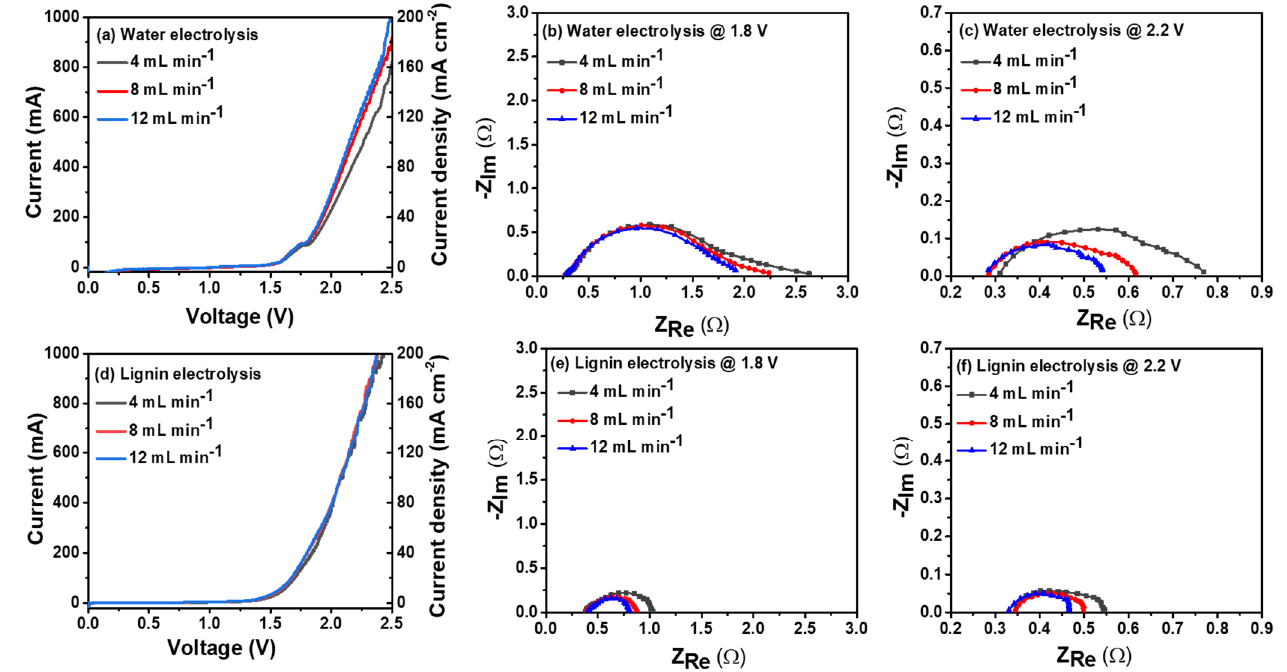
Figure 3. Effect of flow rate on the performance determined by performing linear sweep voltammo- gram (LSV) for ( a ) water electrolysis and ( d ) lignin electrolysis. The change in the ohmic and charge transfer resistance concerning the flow rate is determined by electrochemical impedance spectroscopy (PEIS) for water electrolysis ( b , c ) and lignin electrolysis ( e , f ).